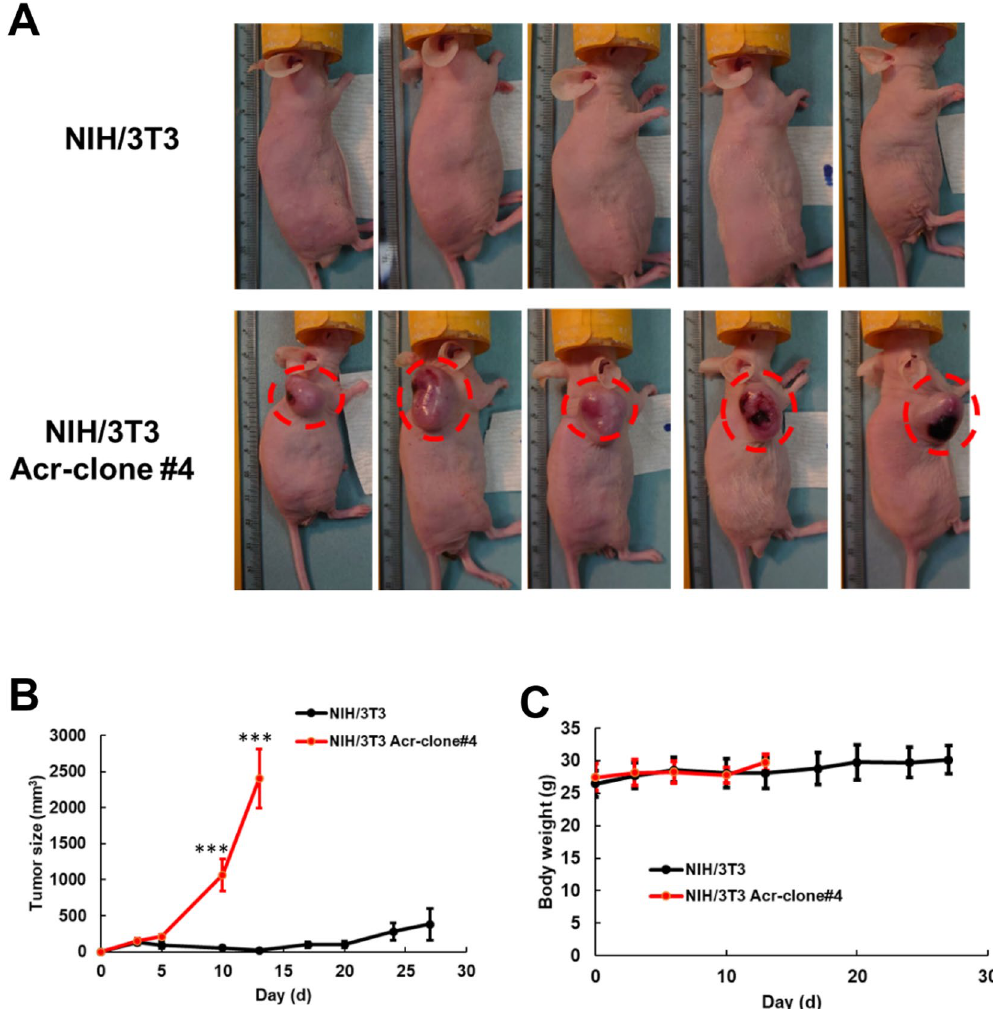
Figure 2. Xenograft mouse model of acrolein-transformed clones. (A) Overall view of tumors formed by acrolein-transformed NIH/3T3 cell clone (Acr-clone#4). Tumors in nude mice were observed after injection with acrolein-transformed clone #4, whereas none were observed after injection with mouse fibroblasts or NIH/3T3 cells. (B) Tumor growth curves and (C) body weight of nude mice in different experimental groups (n = 5). Student’s t tests were used to determine statistical significance, and two-tailed p-values are shown. ***p < 0.005 compared with NIH/3T3 parental